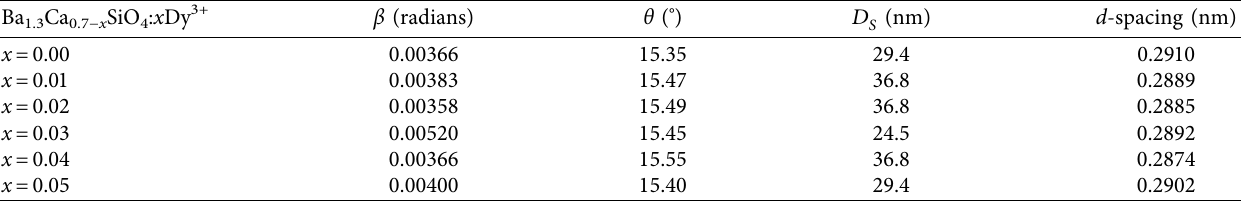
Figure 1: (a) XRD patterns of the silicate phosphors, Ba 3+ ( x � 0.00, 0.01, 0.02, 0.03, 0.04, and 0.05). (b) Magnification of 1.3 Ca 0.7 − x SiO 4 : x Dy the most intense (110) peaks with doping concentration. Table 1: Crystallite size ( D 3+ ( x � 0.00, 0.01, 0.02, 0.03, 0.04, and 0.05), as a function of Dy 3+ S ) of the silicate phosphors, Ba 1.3 Ca 0.7 − x SiO 4 : x Dy doping